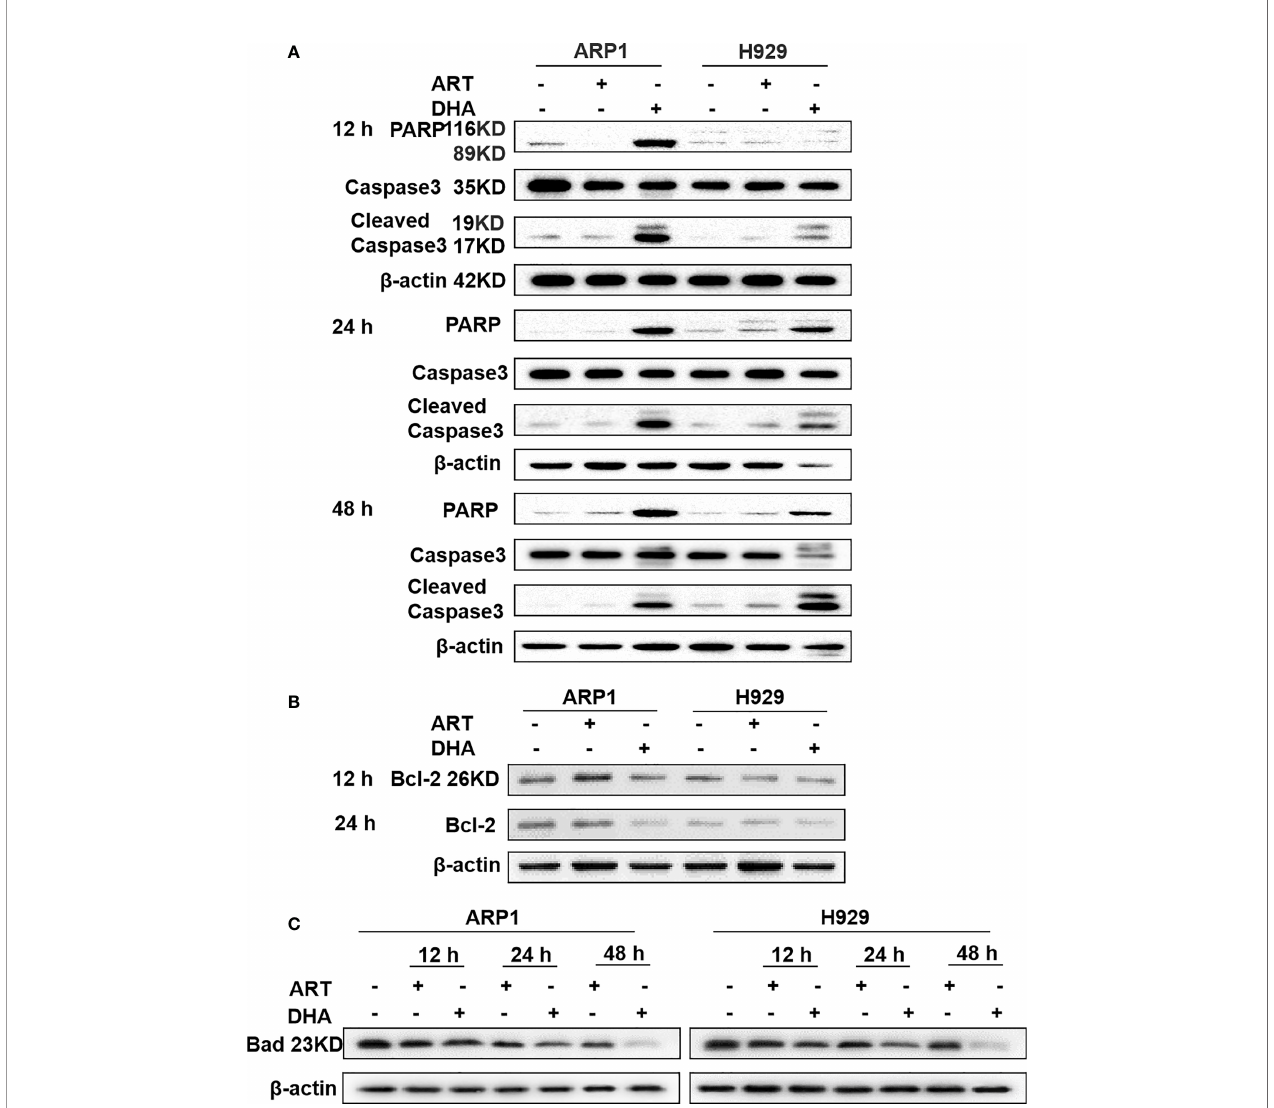
FIGURE 3 | DHA induces caspase-mediated apoptosis in MM cell lines. (A – C) The protein levels of caspase-3, PARP, Bcl-2, and Bad were determined by western blotting in MM cells. The results showed that caspase-3 and PARP were increased after 12 h, while Bcl-2 and Bad were decreased after 12